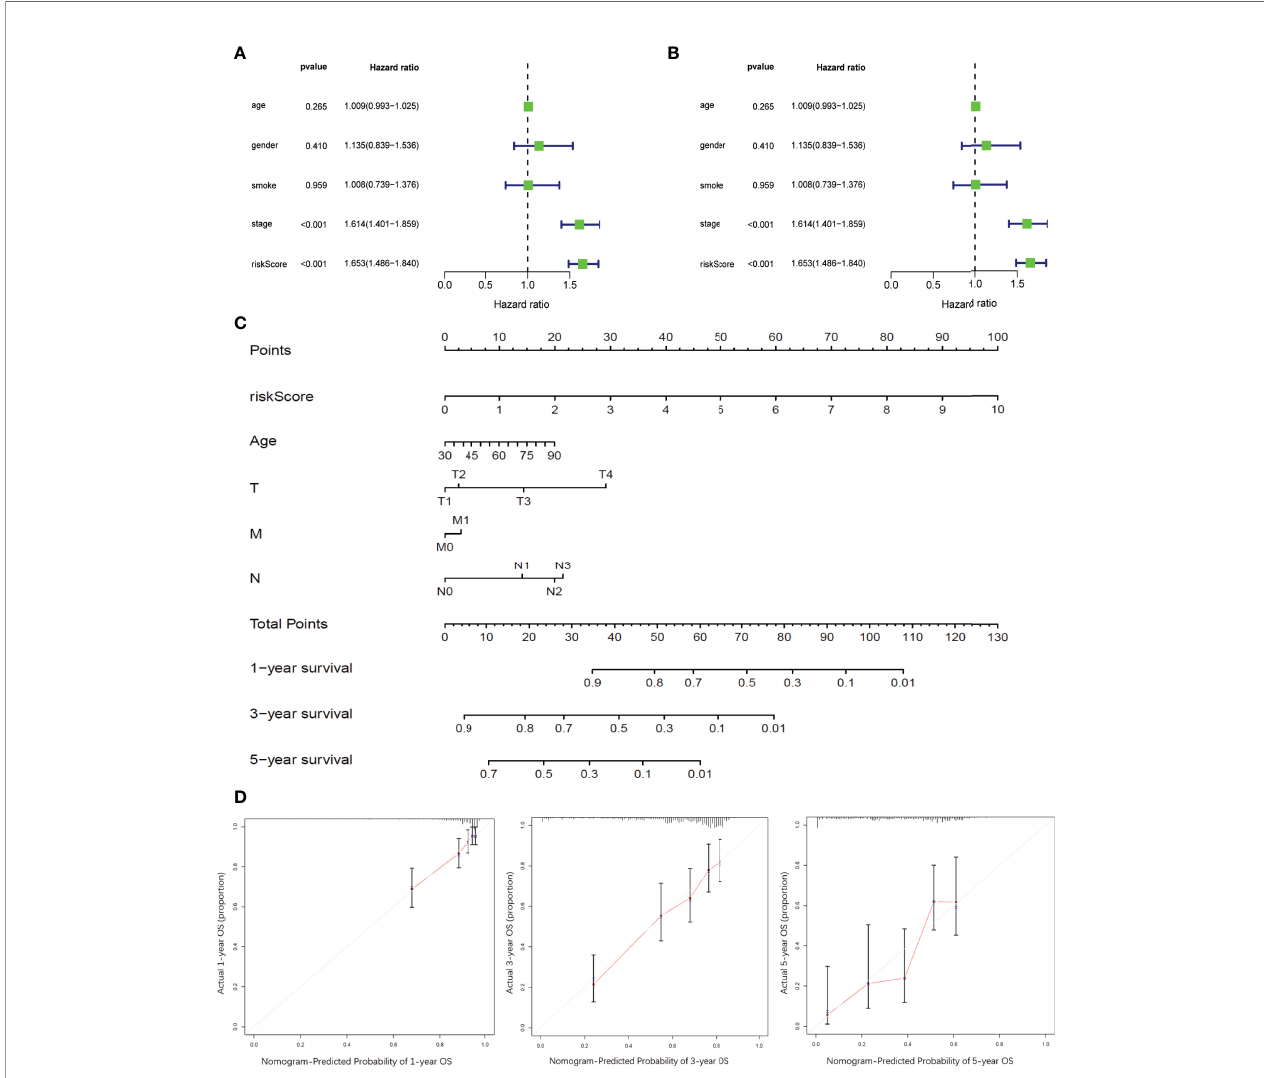
FIGURE 7 | Development and validation of prognostic nomogram integrating RiskScore and conventional prognostic markers (A, B) . Forest plots showing the impact on overall survival of different risk factors as inferred by univariate analysis (A) and multivariate analysis (B) . (C) Nomogram model to predict the prognosis of LUAD patients based on TCGA training cohort. Age, sex, smoking history, tumor stages, and RiskScore inferred by hub DRGs. (D) Calibration plots of the prognostic nomogram for predicting overall survival at 1, 3, and 5 years in the